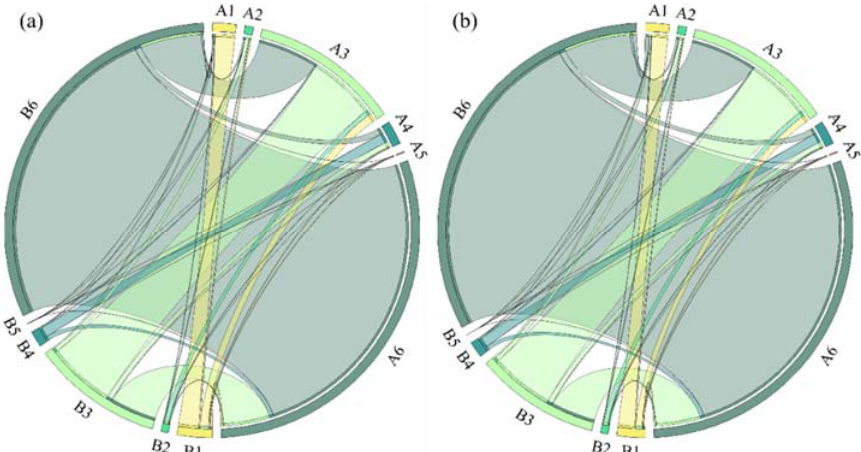
Figure 7. Map of future land use shifts in the Tarim River Basin. ( a ) 2020–2030, ( b ) 1992–2030. A1–A6 are the land types in the starting years, B1–B6 are land types in the end years. (A1/B1: Cropland; A2/B2: Grassland; A3/B3: Woodland; A4/B4: Built-up land; A5/B5: Water bodies; A6/B6: Barren land).